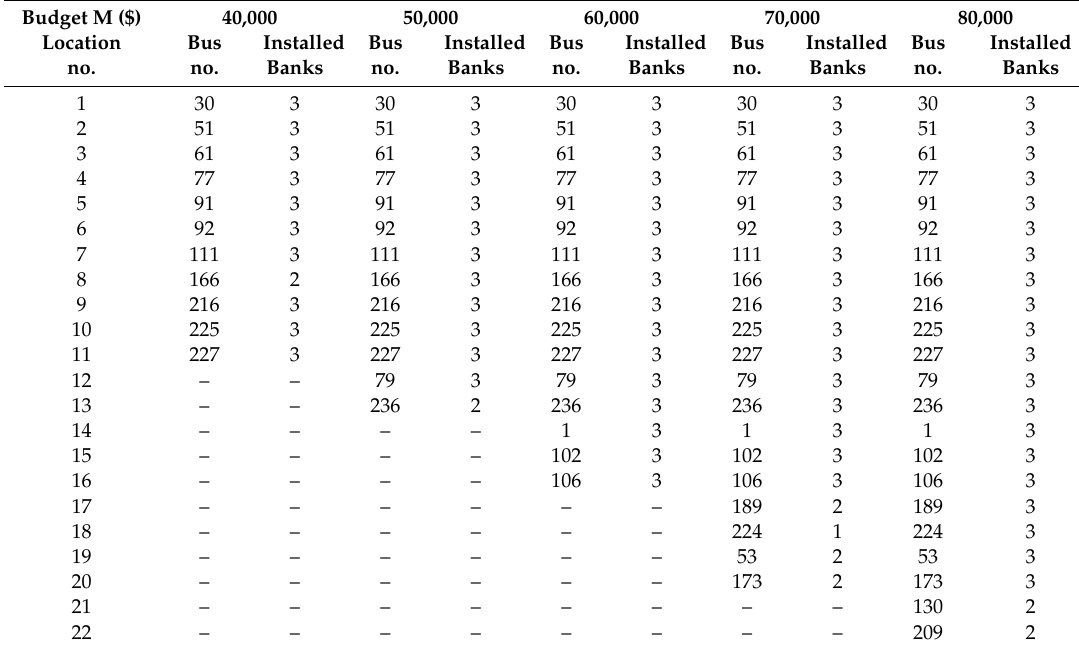
Table 4. Reactive volt-ampere locations and installed banks of the IEEE 244-Bus system. Budget M ($) Location